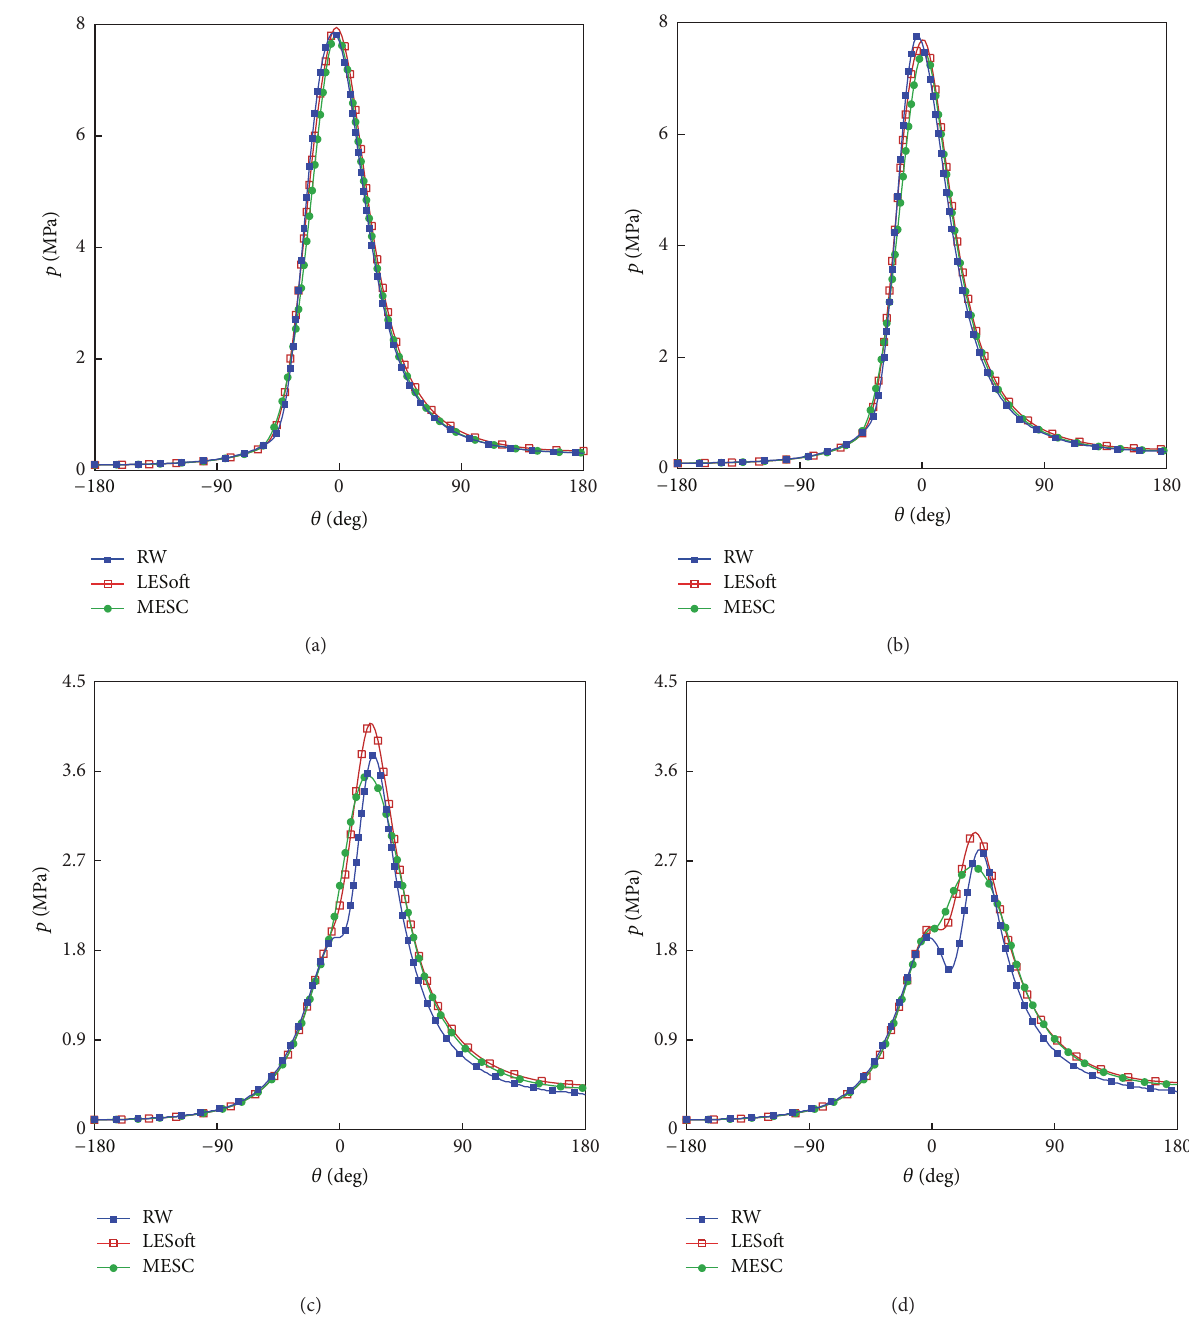
Figure 11: Profiles of pressure for different ignition timing of − 60 (a), − 50 (b), − 10 (c), and 0 (d) degrees.